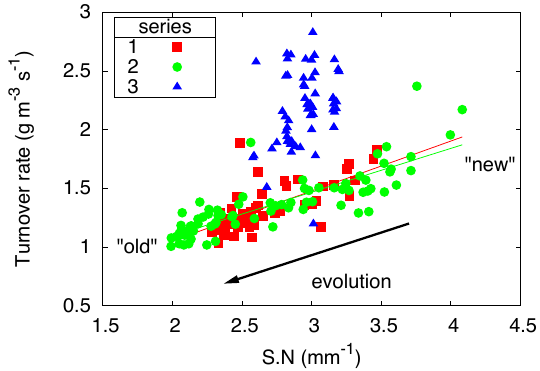
Fig. 10. Correlation between the turnover rate and the geometrical parameter S.N. Symbols represent the measured data, correlations for Series 1 and 2 are shown by trend lines (linear regression); no trend line was drawn for Series 3. The arrow indicates the evolution from “newer” to “older” snow.